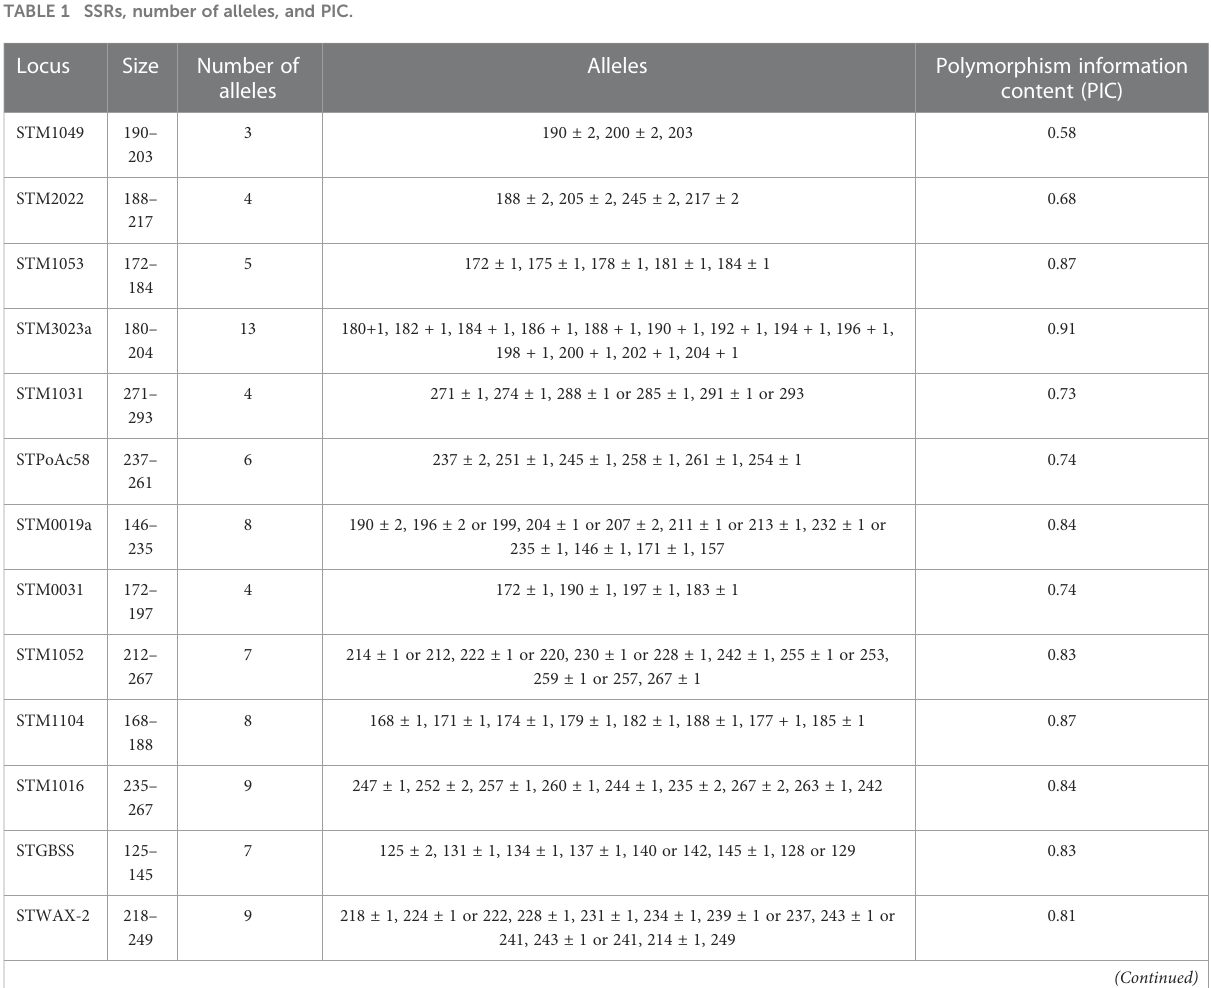
TABLE 1 SSRs, number of alleles, and PIC. Locus